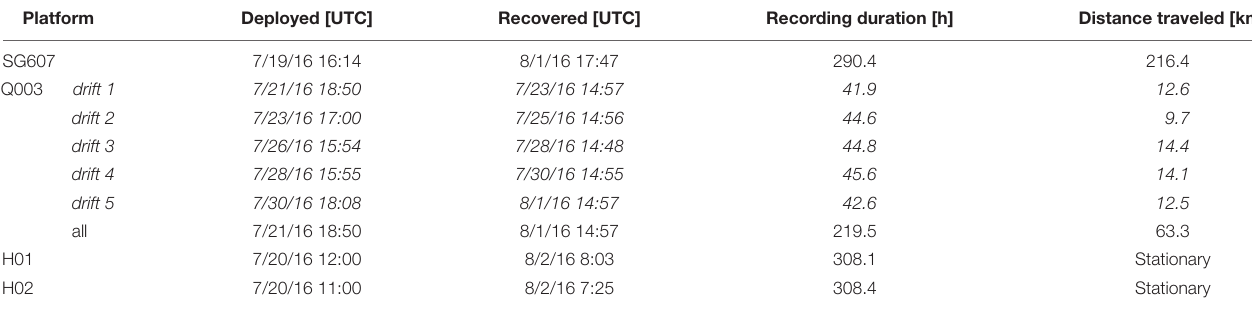
TABLE 1 | Deployment and recovery times for each recording platform (Seaglider – SG607, QUEphone – Q003, and HARPs – H01 and H02).